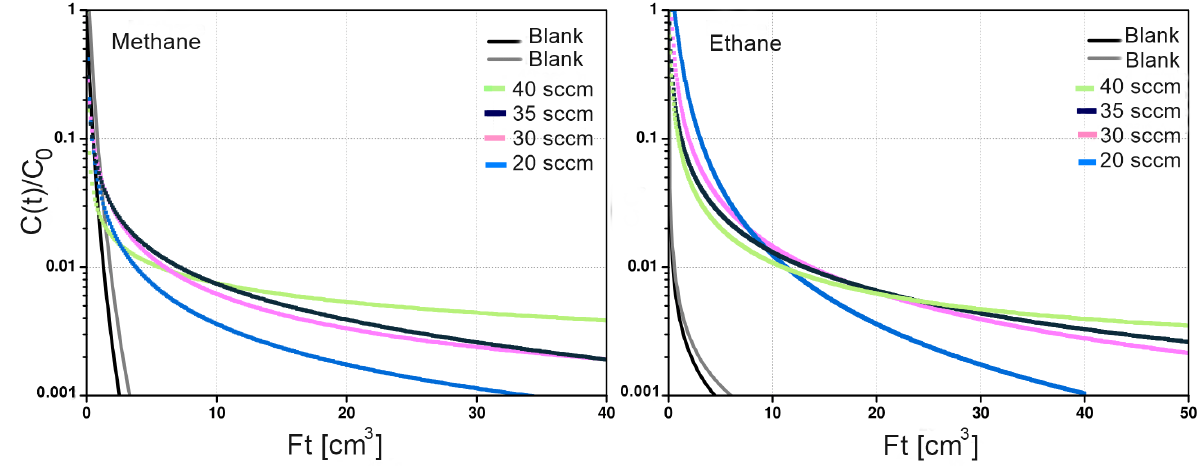
Figure 9. Desorption curves of Basolite ® C300 at different methane and ethane flow rates at